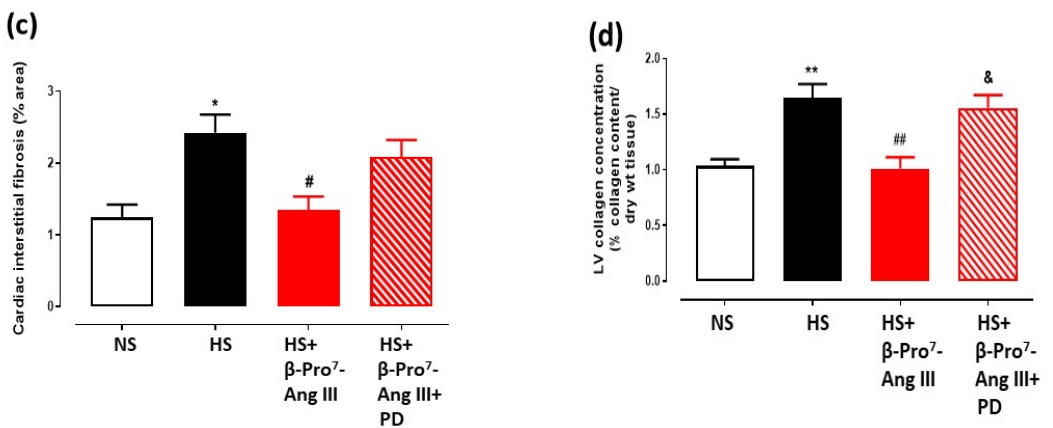
Figure 1. Representative ( a ) bright view and ( b ) polarized view for interstitial fibrosis sections stained with picrosirius red (indicated by red) in left ventricle (LV) obtained from male FVB/N mice fed on a normal salt (NS, 0.5% NaCl) diet or mice fed on a high salt (HS, 5% NaCl) diet in the presence or absence of β -Pro 7 -AngIII (0.1 mg/kg/day) +/ − PD123319 (1 mg/kg/day). Scale bar for all images = 50 µ m. ( c ) Group data of % area of interstitial fibrosis in LV sections. ( d ) Total tissue collagen measured by hydroxyproline assay in LV tissue from same animal groups in which picrosirius red staining was performed (n = 7–8 per group). All data are expressed as mean ± s.e.m. * p < 0.05, * * p < 0.01 vs. sham; # p < 0.05, ## p < 0.01 vs. HS; & p < 0.05 vs. HS+ β -Pro 7 -AngIII, determined by One-Way ANOVA with Tukey correction for multiple comparisons.